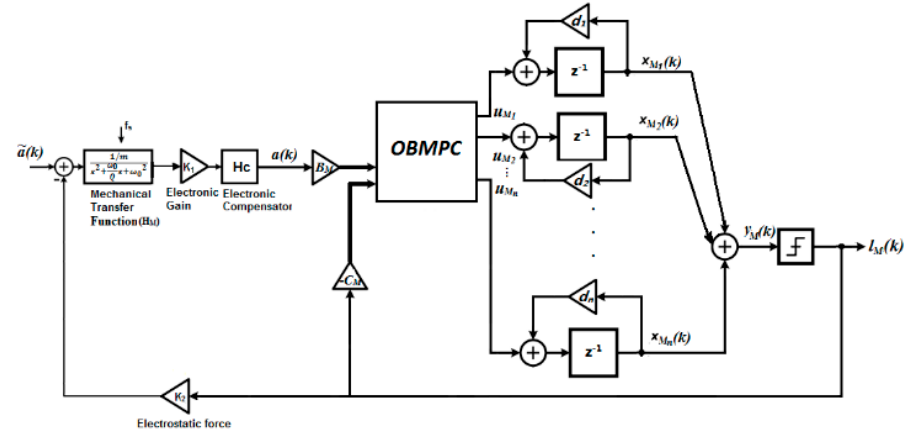
Figure 8. MEMS gyroscope using the OBMPCbased Δ∑ modulator (Thick lines denote vector routing).